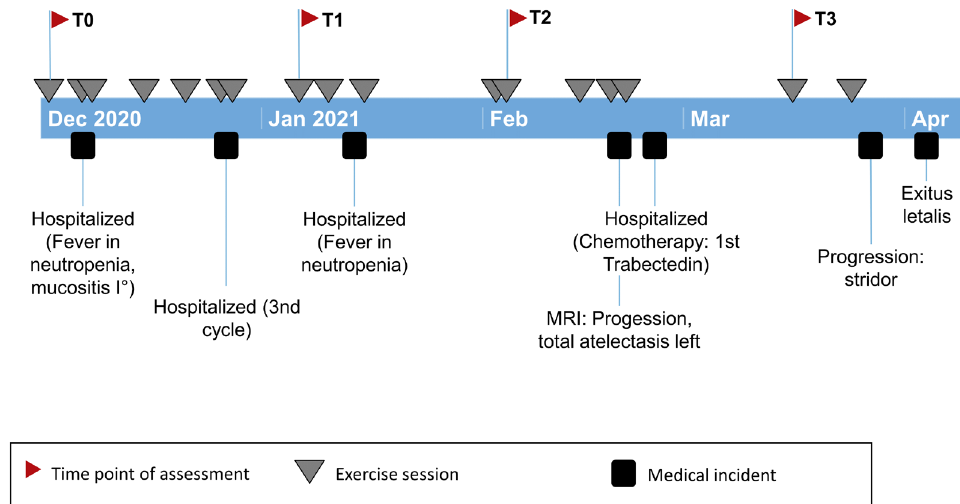
Figure 1. Timeline of 13-year-old female with alveolar rhabdomyosarcoma during the exercise project from December 2020 until April 2021, with four timepoints (T0–T3), marked exercise sessions (grey triangle) and medical events (black square).